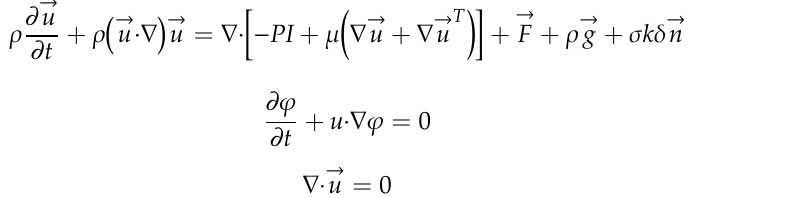
Figure 2. Created mesh for a crossed part of the channel.